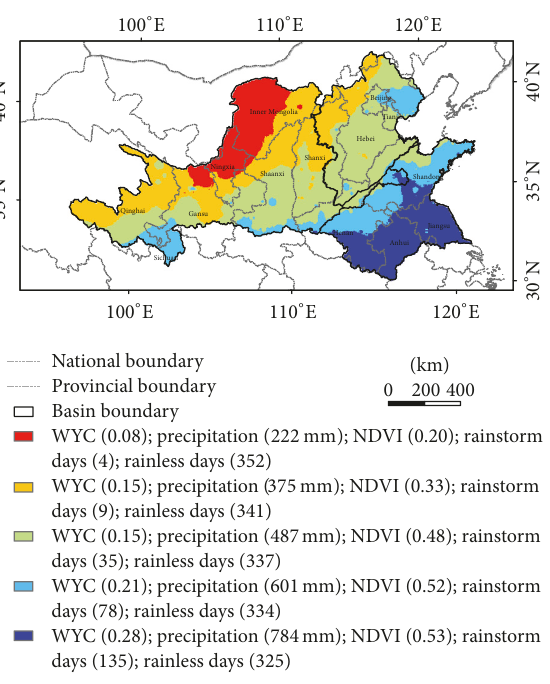
Figure 24: Cluster